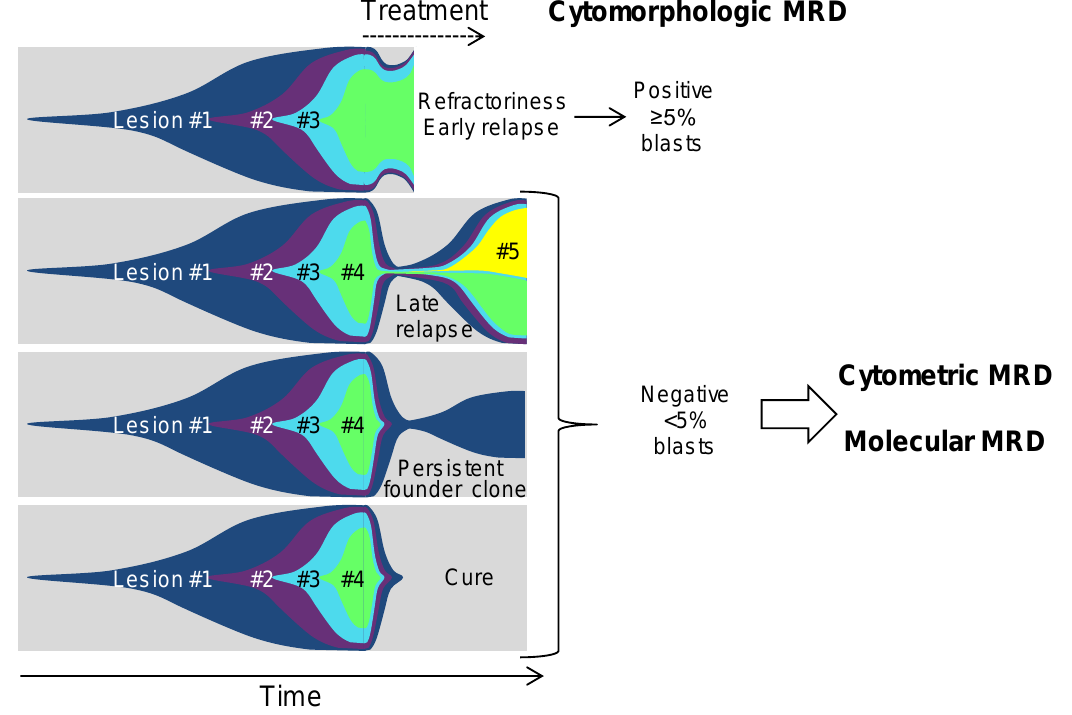
Figure 2. Possible outcomes in AML. Fish diagrams showing clonal evolution in the four possible AML outcomes. Refractoriness and early relapse are diagnosed using cytomorphology and are characterized by the early persistence of most, if not all, lesions, found at the diagnosis. Later relapse occurs after a period of complete remission, where no excess blast is seen, but where most lesions persist at low levels. A peculiar condition is represented by the persistence of clonal hematopoiesis in patients who are in long-lasting remission but retain a founder clone with the most frequent DNMT3A mutations. Finally, patients are cured when all mutant cells are cleared from the bone marrow. In these last three outcomes, cytometric and molecular measurable residual diseases (MRD) evaluations are critical for patient monitoring. #1, #2, #3 etc. indicate the successive genetic lesions.